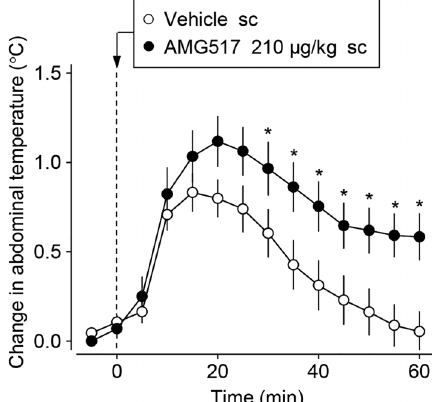
Figure 2. Systemic administration of a TRPV1 antagonist induces hyperthermia. The fi gure shows that subcutaneous injection of AMG517 (210 m g/kg, sc ) increases the abdominal temperature of young mice maintained at 28°C. *Signi fi cant difference (P o 0.05) compared to vehicle. TRPV1: transient receptor potential vanilloid type 1. The fi gure was modi fi ed from Wanner et al., 2012